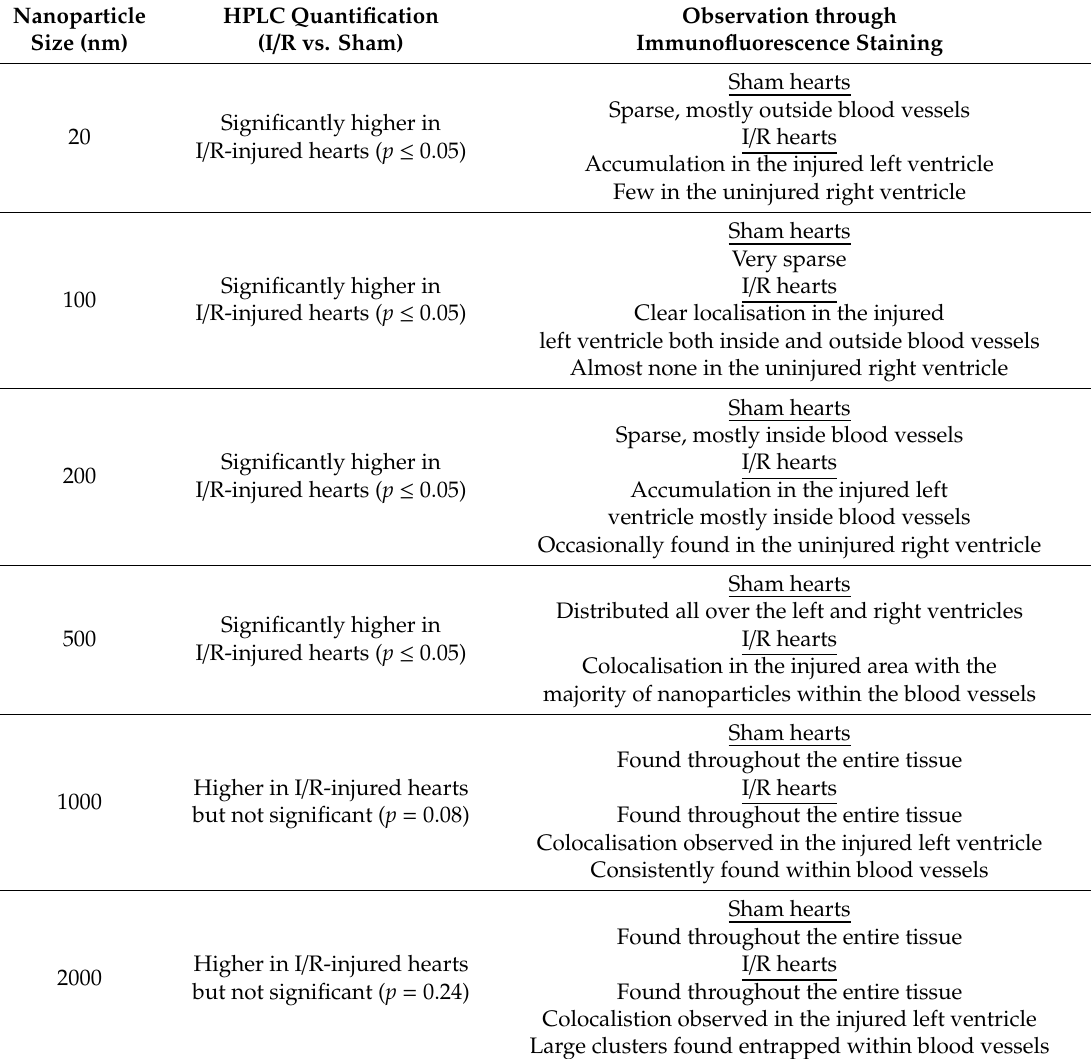
Table 1. Size-dependent e ff ect of nanoparticle biodistribution in mice, post-ischaemia / reperfusion (I / R) injury.